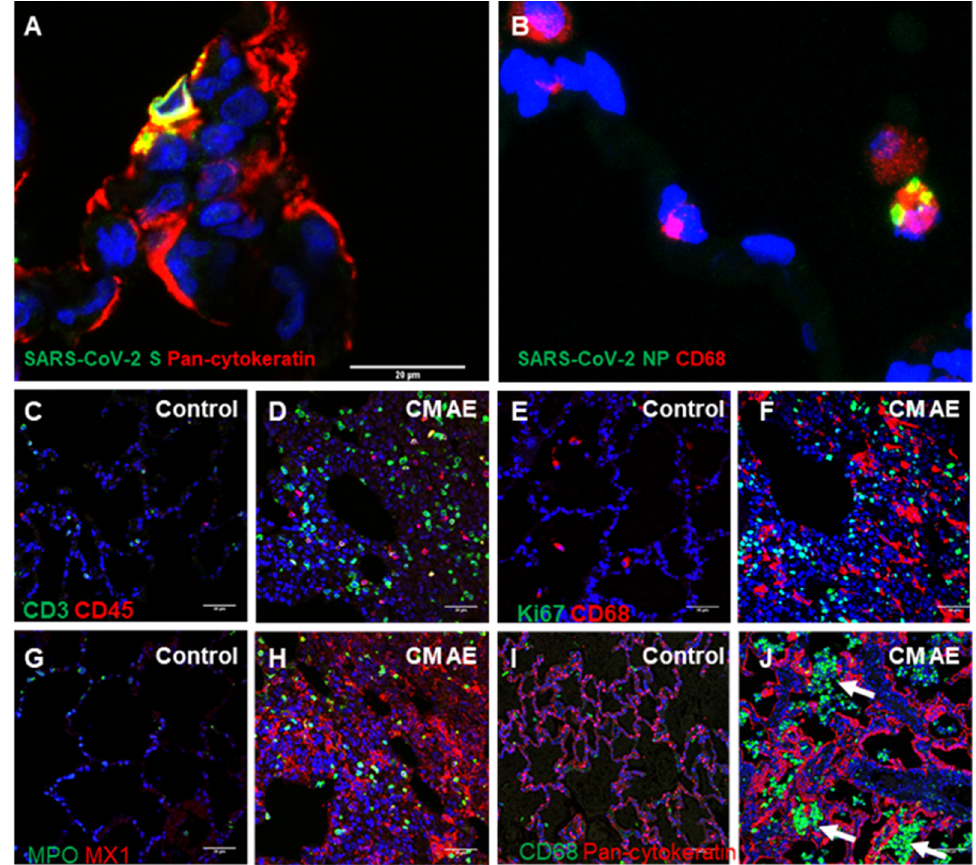
Figure 7. The cellular targets of SARS-CoV-2 and inflammatory infiltrates in the lungs of cynomolgus macaques (CM) exposed by aerosol (AE). ( A ) The spike (S) protein of SARS-CoV-2 (green) was detected in pneumocytes (red) labelled by anti-pan-cytokeratin antibody (red). ( B ) The nucleopro- tein (NP) of SARS-CoV-2 (green) was detected in CD68+ macrophages (red). ( C – H ) In comparison to uninfected control lung tissue, CD3+ T cells (green in ( C , D )), CD45+ leukocytes (red in ( C , D )), CD68+ macrophages (red in ( E , F )), and Ki67+ proliferating cells (green in ( E , F )), MPO+ polymor- phonuclear cells (neutrophils, eosinophils, and basophils, green in ( G , H )), expression of the type 1 interferon-induced GTP-binding protein Mx1 (a readout of type 1 interferon response, red in ( G , H )) in the lungs of CM AE NHPs exposed to SARS-CoV-2. ( I , J ) Alveolar spaces were congested by CD68+ macrophages (green, arrows) in some areas of the lungs of CM AE animals. Lung epithelium is stained outlined by anti-pan-cytokeratin antibody (red). Nucleus stained by DAPI (blue).